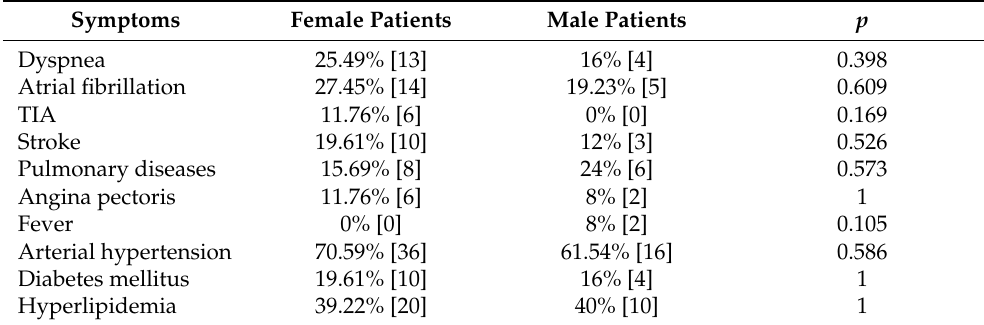
Table 2. Differences in symptoms between female and male patients ( n female = 64, n male = 16).